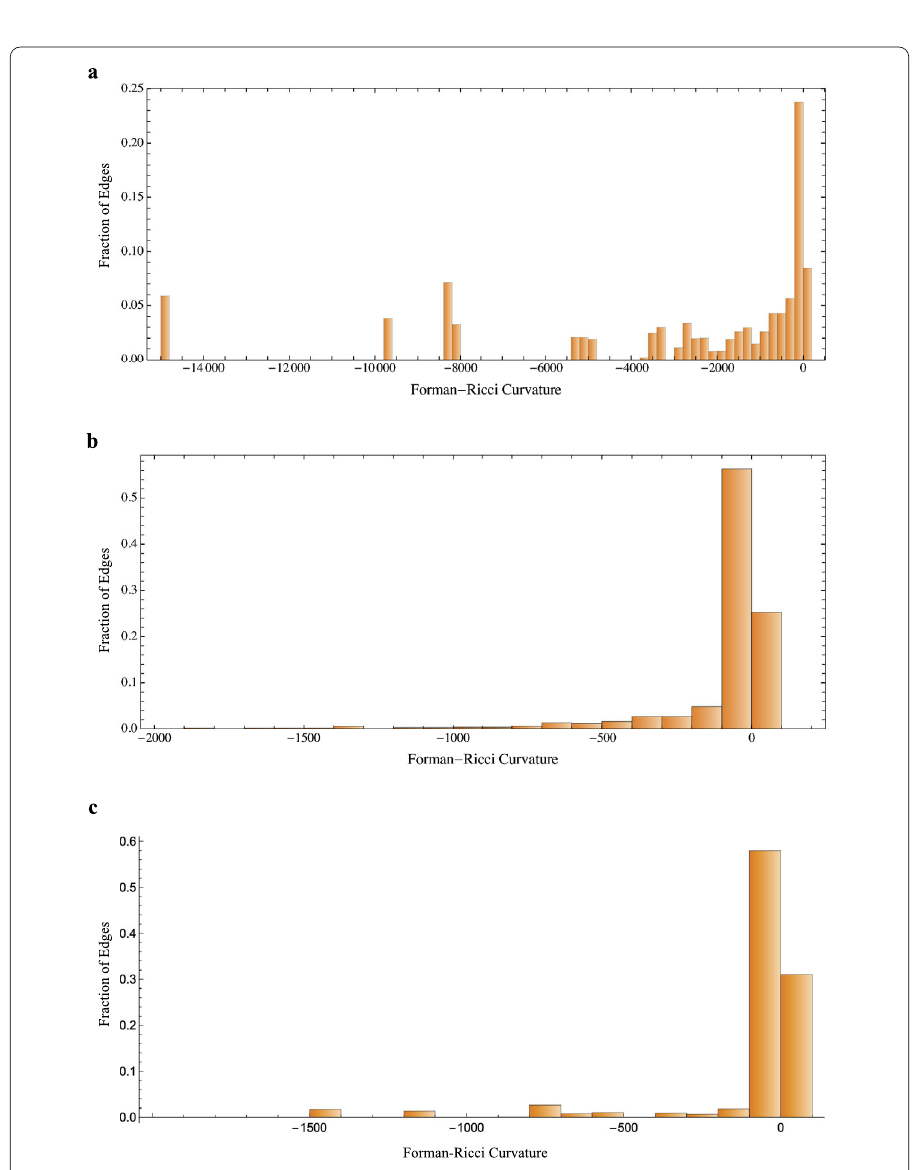
Figure 6 Forman–Ricci Curvature Histograms. The figures show histograms for the values of the Ricci–Forman curvature corresponding to the edges (i.e., interactions) of: ( a ) The Bahamas Leaks network. ( b ) The Panama Papers network. ( c ) A randomly generated scale-free network with comparable size